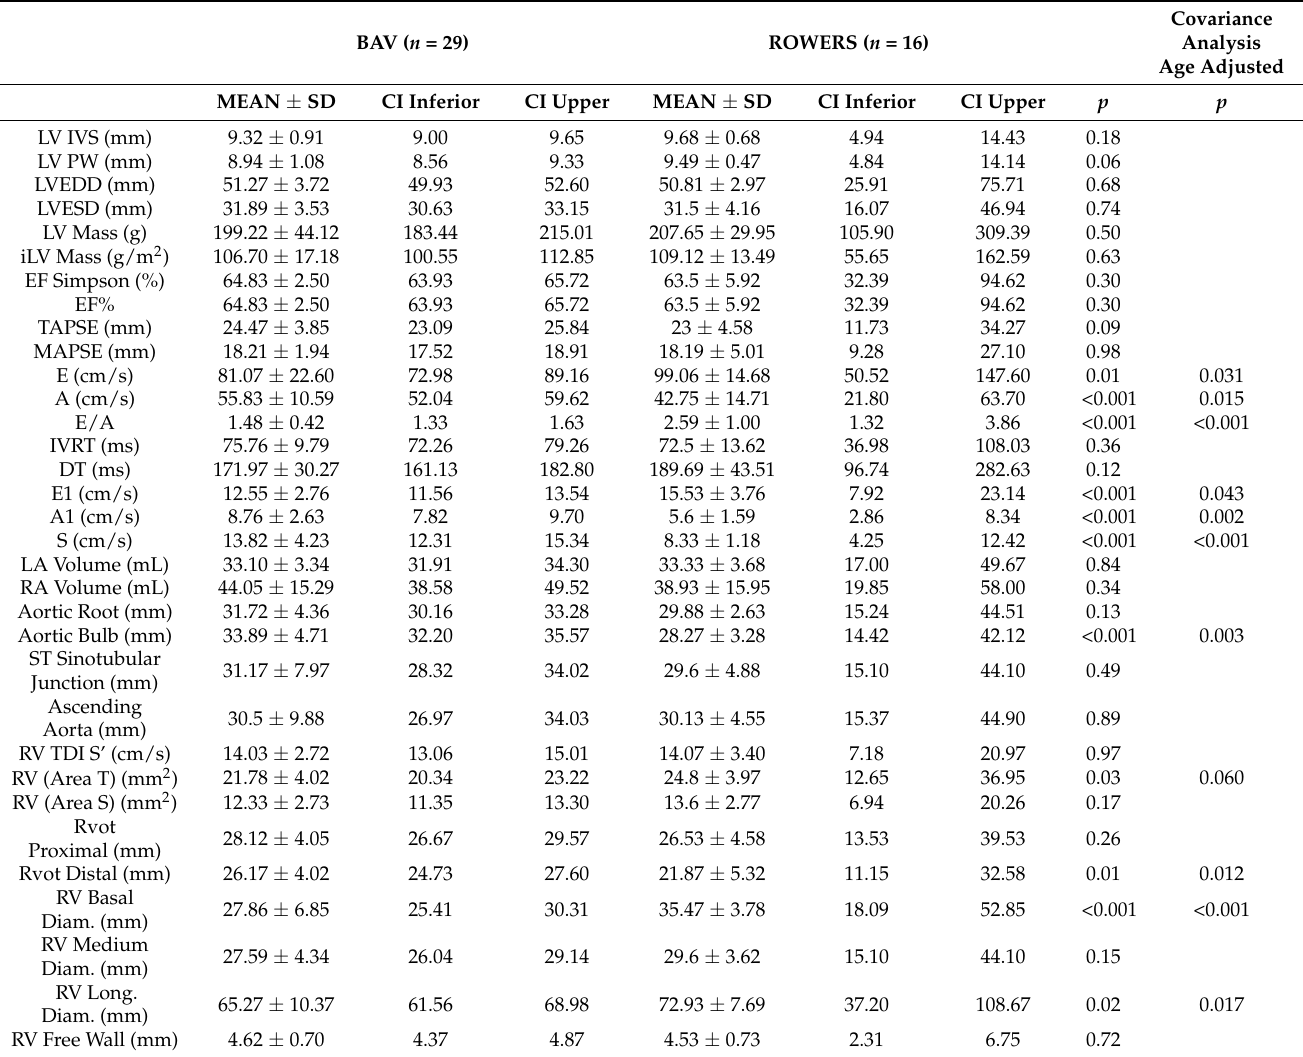
Table 2. Echocardiographic parameters of the